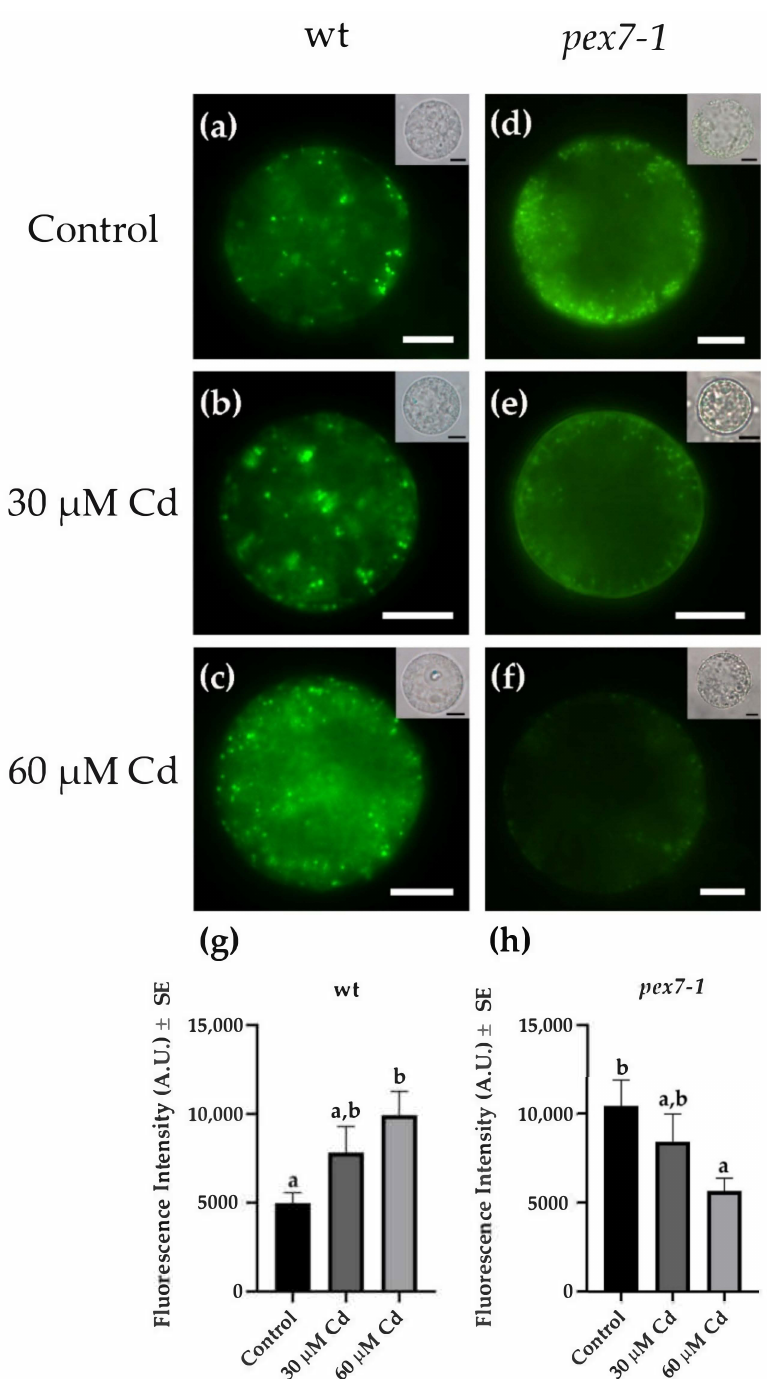
Figure 4. N-Bodipy epifluorescence signal in wt ( a – c ) and pex7-1 ( d – f ) root protoplasts from seedlings grown in the absence (( a , d ), Control) or in the presence of 30 µ M CdSO 4 (30 µ M Cd) ( b , e ) or 60 µ M CdSO 4 (60 µ M Cd) ( c , f ). Insets in ( a – f ) show the same field under white light. ( g , h ) Mean values ( ± SE) from three biological replicates of N-Bodipy fluorescence intensity in root protoplasts of the same size (~200 µ m 2 ) measured using ImageJ software (version 1.53c, Wayne Rasband, National Institutes of Health, Bethesda, USA) and expressed in arbitrary units (A.U.s; from 0 to 255). Columns labelled with different letters among treatments show statistical differences for at least p < 0.05 level. Columns labelled with the same letter are not statistically different ( p > 0.05). Bars = 7 µ m ( a – c ) and 10 µ m ( d – f ). n =